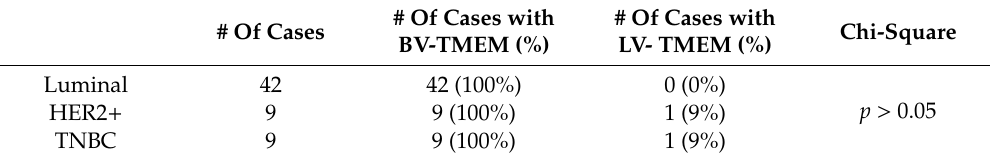
Table 4. Association of BV-TMEM and LV-TMEM with breast cancer subtypes in a patient cohort. # Of Cases with # Of Cases with # Of Cases Chi-Square BV-TMEM (%) LV- TMEM (%) Luminal 42 42 (100%)